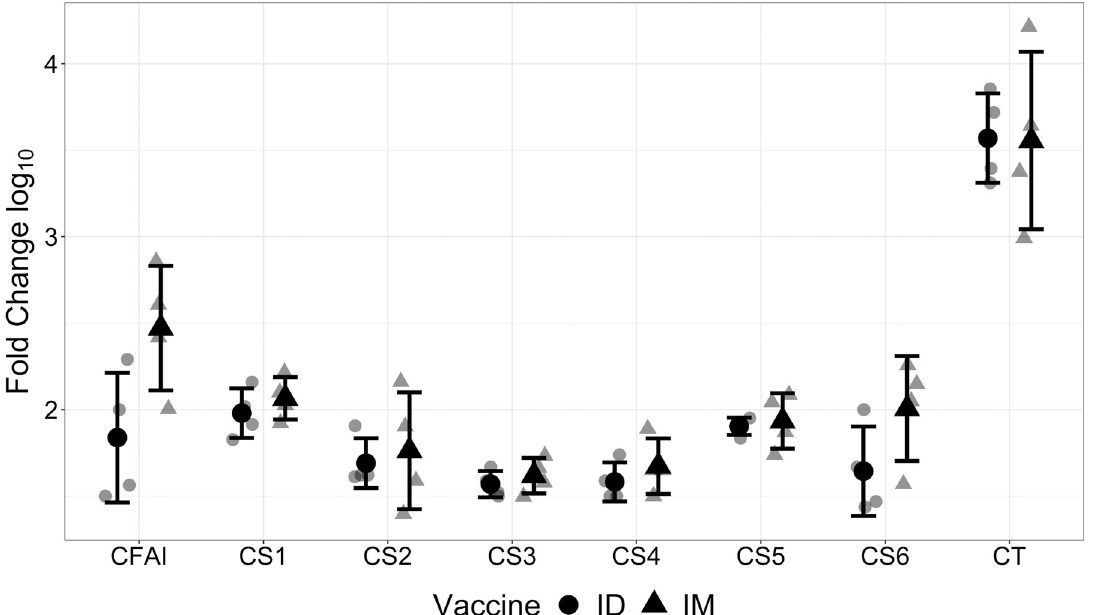
Fig 1. Fold change in IgG antibody titers when compared to control serum (from non-vaccinated rabbits) for various CFAs in rabbit serum. Serum samples of each rabbit intramuscularly (triangles) or intradermally (circles) vaccinated with CFA/I/II/IV MEFA protein, with dmLT adjuvant, were titrated in ELISAs with CFA/I, CS1, CS2, CS3, CS4, CS5 adhesin, CS6 CssA recombinant protein, or CT (for LTB) as coating antigens. Rabbits were immunized twice, with a period of two weeks between doses. Mean and standard deviations are shown in black, individual fold changes in